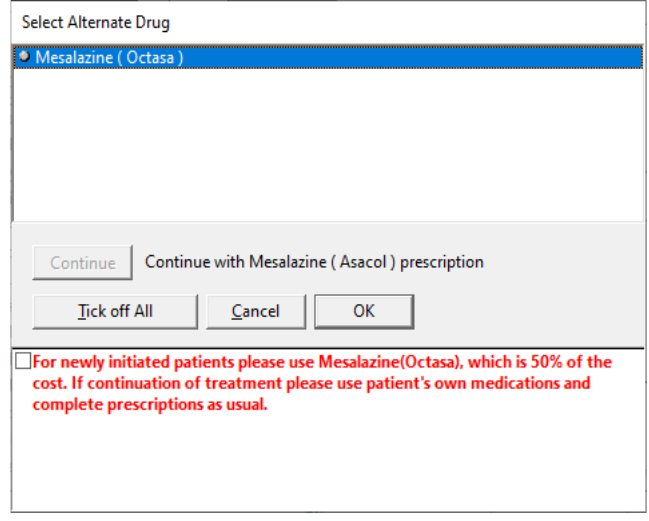
Figure 2. Nudge presented in the PICS prescribing system.